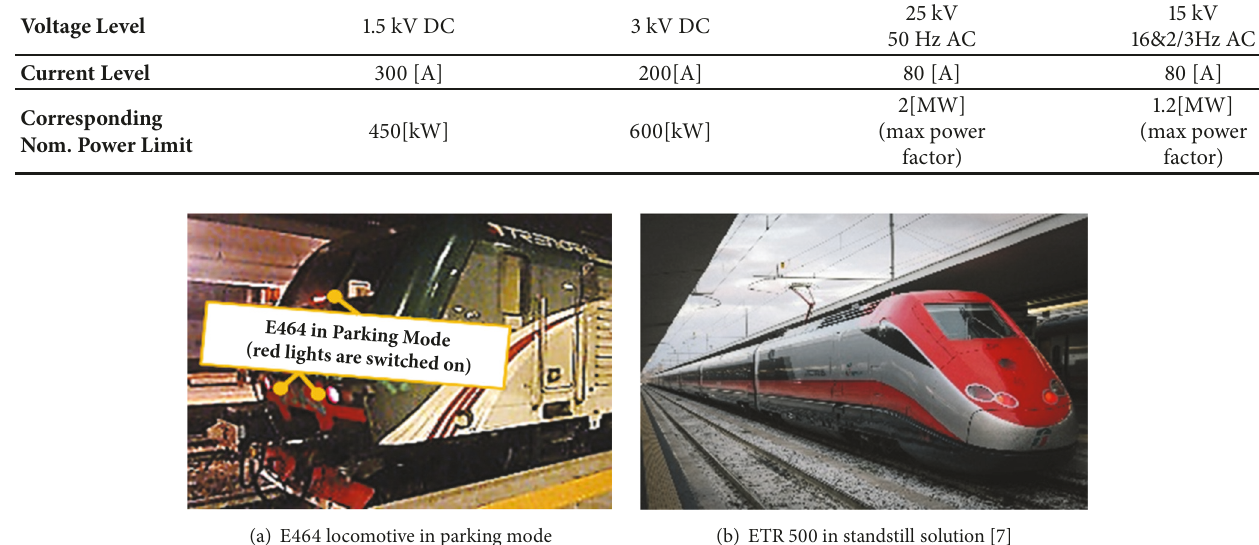
Table 1: Current limitation in standstill conditions according to regulations in force [6, 7].